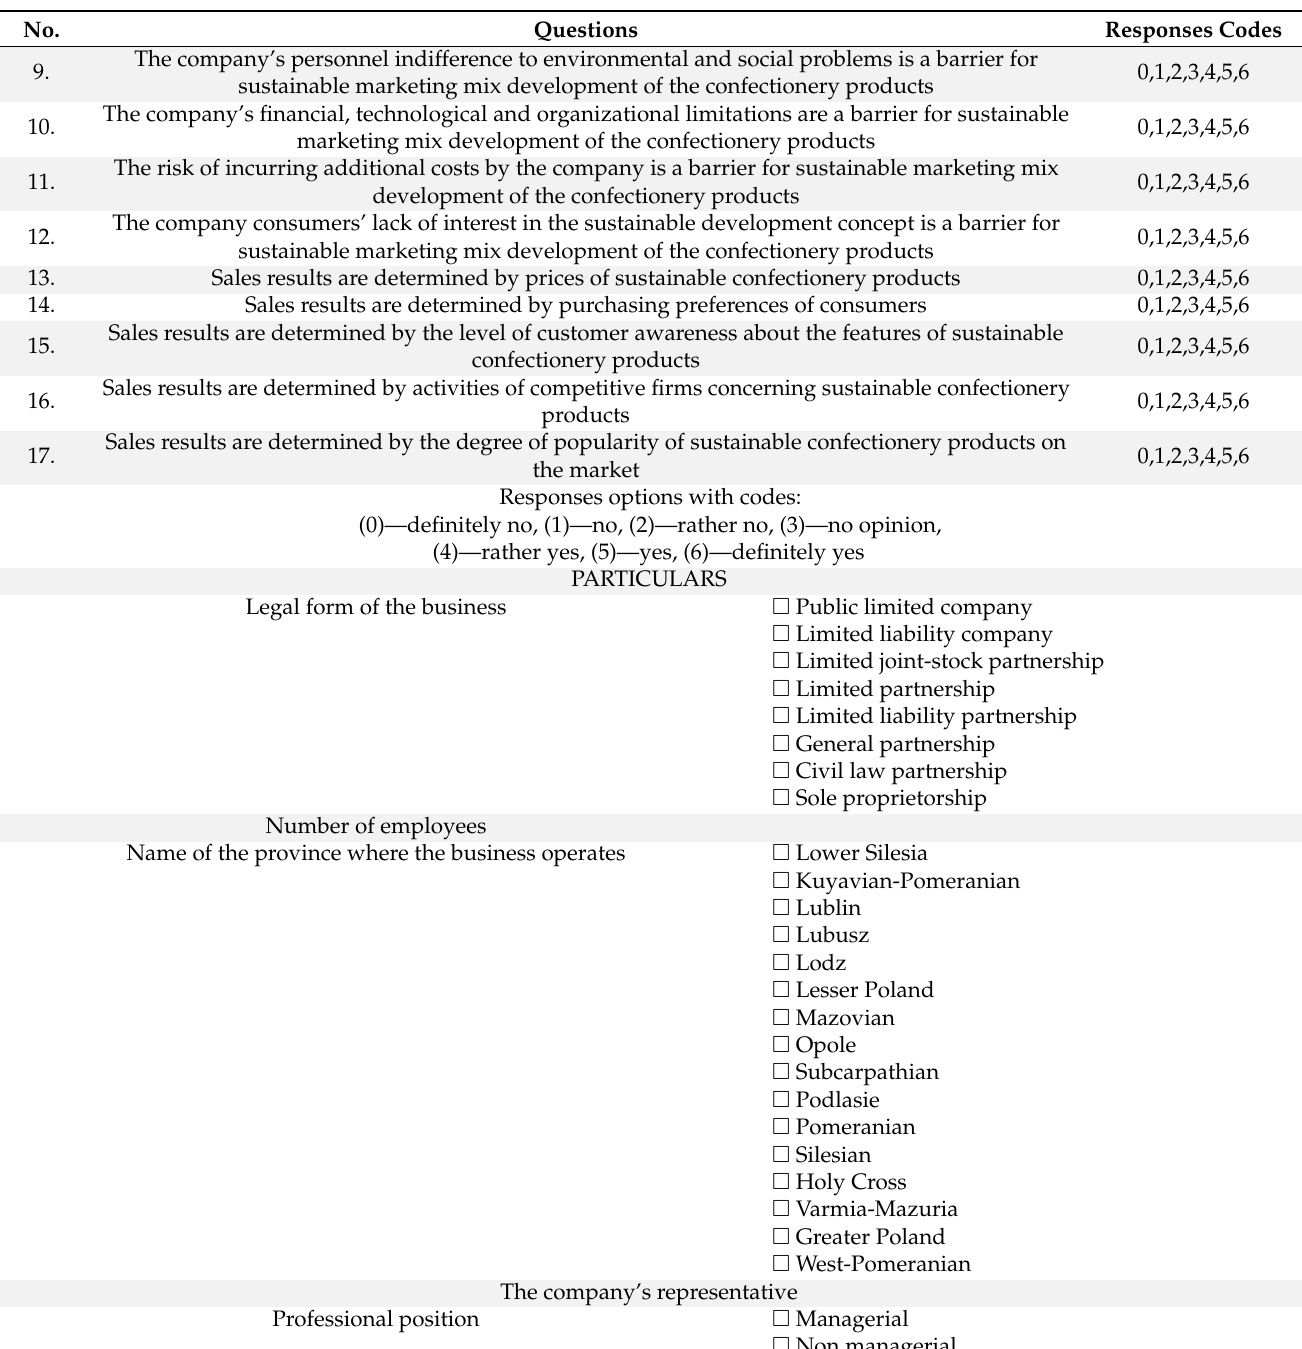
Table A1. The questionnaire